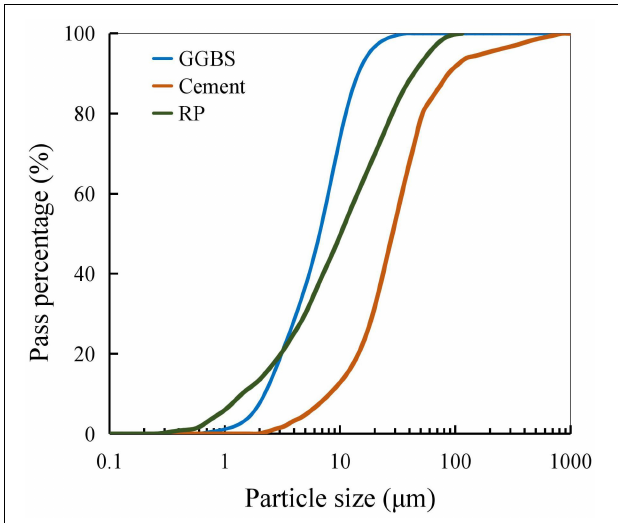
FIGURE 1 | Particle size distributions of the component.